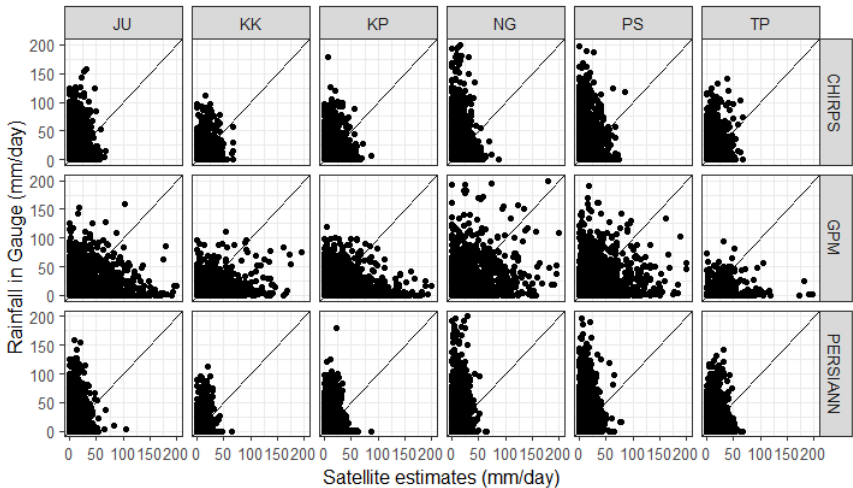
Figure 3. Scatter plots between rainfall from gauges and satellite products from all observation